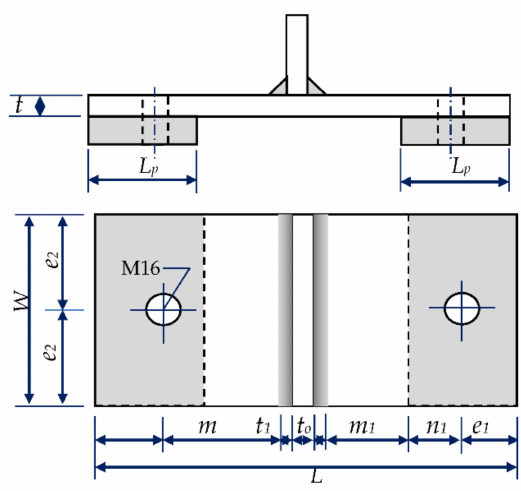
Figure 3. Elevation view and cross-section of the T-stub connection with inserted